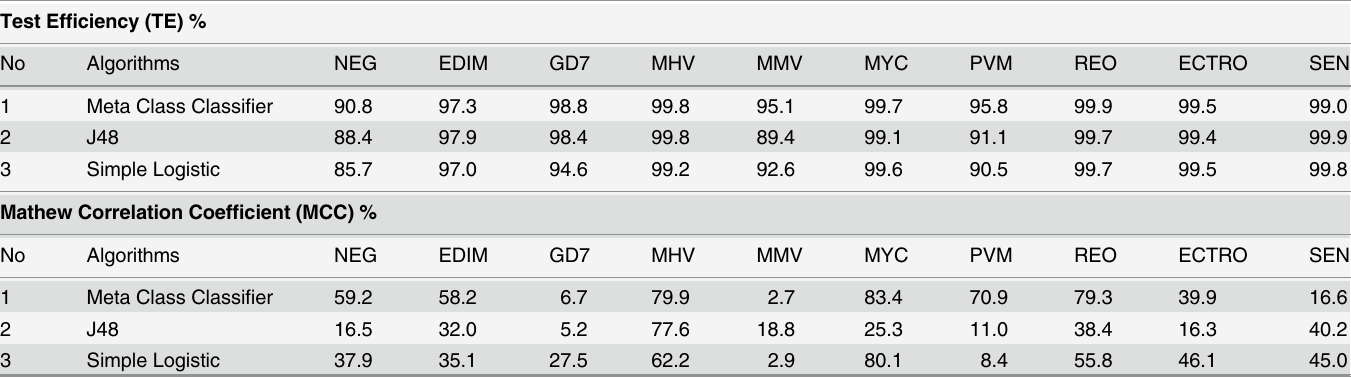
Table 3. Performance evaluations of the test set using the training